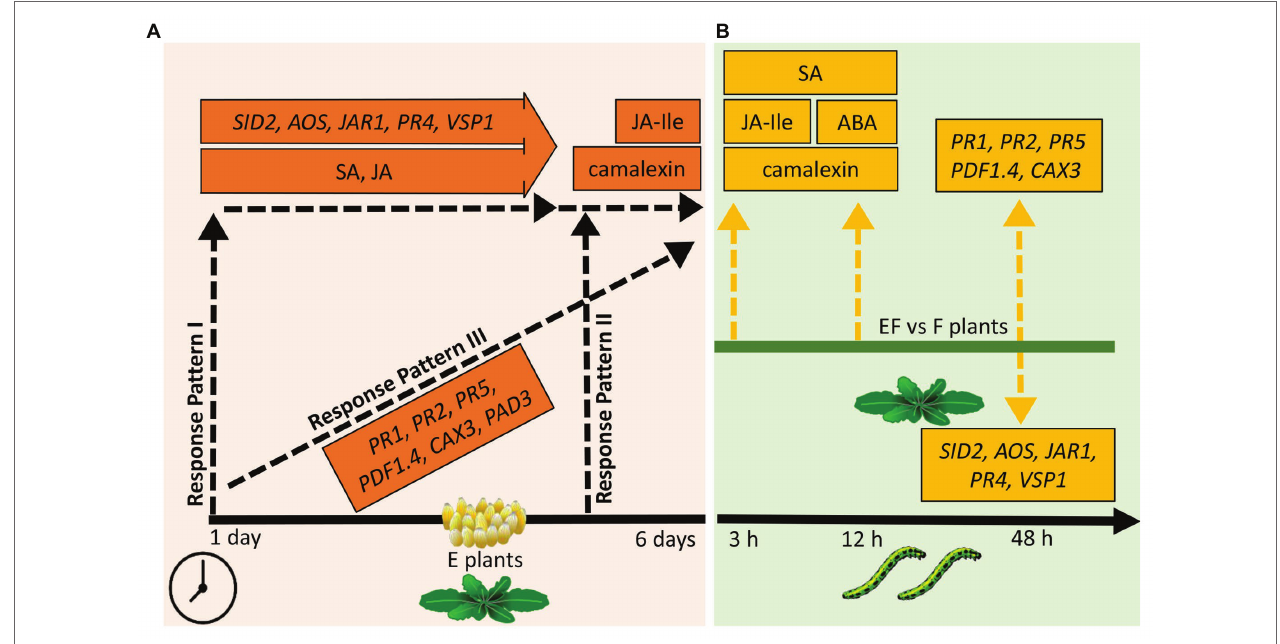
FIGURE 7 | Overview of results of the phytohormone, camalexin, and gene expression measurements. (A) Responses of plants to eggs. Response pattern I: traits significantly increased 1 day after egg deposition, almost kept the increased level for several days but showed no further significant increase. Response pattern II: traits significantly increased only 5–6 days past egg deposition. Response pattern III: traits significantly increased shortly after egg deposition and showed further significant increase at the end of the egg incubation time. Timeline: measurements 1–6 days after egg deposition. (B) Responses of previously egg-laden plants to feeding. Dashed, yellow arrows pointing upwards (downwards): higher (lower) levels of measured traits in EF plants when compared to F plants; EF: plants exposed to eggs and feeding, F: plants exposed to feeding only. Timeline: measurements 3, 12, or 48 h after onset of larval feeding. Please see text for further